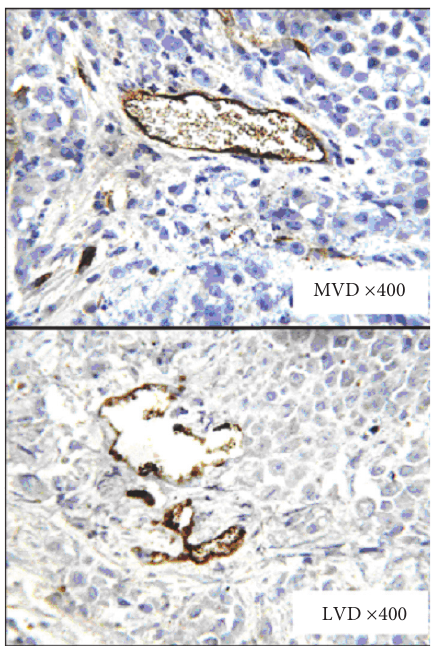
Figure 4: Immunohistochemical analysis of MVD and LVD in cancer cells from transplanted peritoneal tumor nodules (CD34- positive blood vessels and D2-40-positive lymphatic vessels in peritoneal